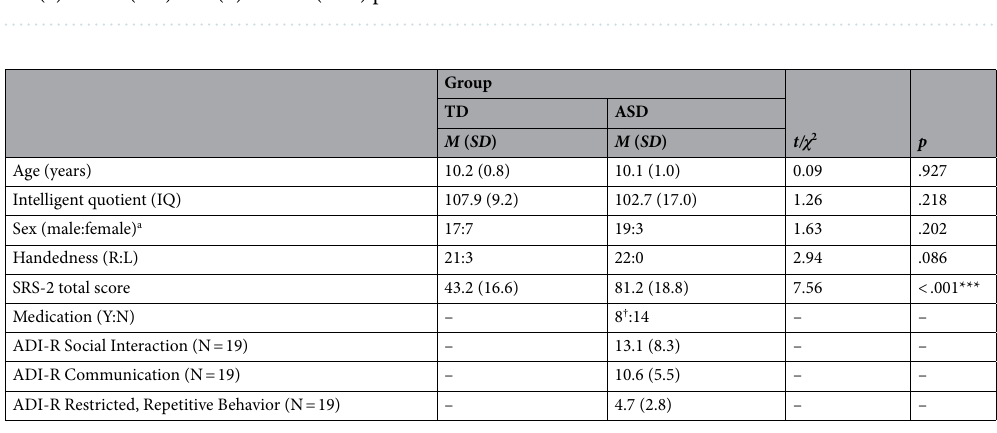
Figure 3. Channel pairs for the intrahemispheric (left) and interhemispheric (right) connectivity measures in the ( a ) lateral (red) and ( b ) medial (blue) prefrontal cortex.